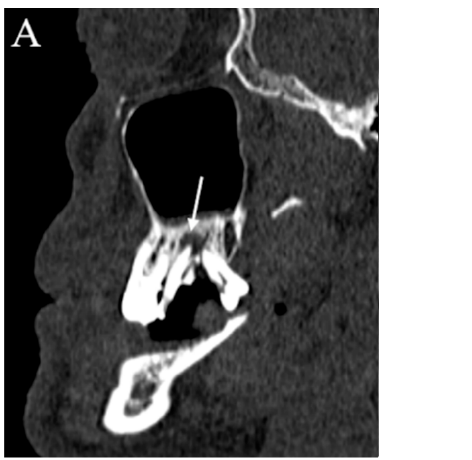
Figure 3. An example of false-negative apical periodontitis. ( B ) Upper jaw MSCT imaging showing apical periodontitis affecting the left second molar. ( A ) In PAN, no periapical bone lesion was detected at the level of the periapex of the left second